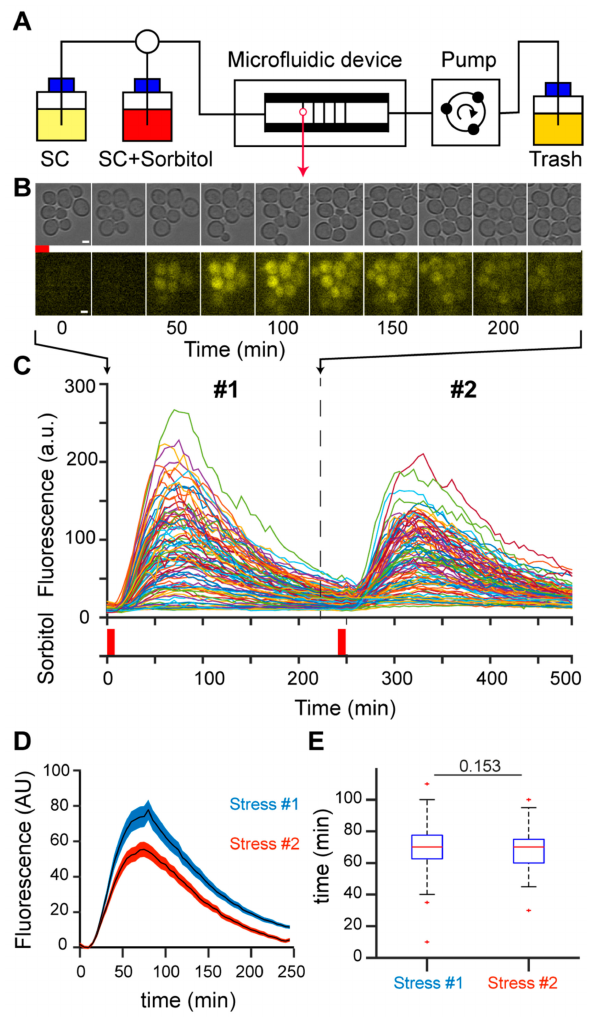
Figure 1. ( A ) Experimental setup. We used multi-layer H-shaped microfluidic devices composed of two large 50 µ m-high and 40- µ m thick flow channels, with 400 µ m × 400 µ m × 3.7 µ m observation chambers. Cells are trapped in the chambers and grow as a monolayer, which facilitates cell segmentation and tracking. The medium flowed through the channels di ff uses into the chambers. Hyperosmotic stress-activated expression of pSTL1-yECRITRINE was triggered by exposure to 1 M sorbitol for 8 min. SC, synthetic complete medium. ( B ) Representative images of cells in the microfluidic chamber exposed to 8 min stress and left to recover for 4 h (240 min), scale bar, 5 µ m. Cells were imaged every 5 min in bright light (20 ms exposure, upper row) and fluorescent light (200 ms exposure, lower row). ( C ) Fluorescent signals for individual cells exposed to two successive 8 min-stresses separated by 4 h. Hyperosmotic stress is indicated by the red bars, # 1 and # 2 indicate first and second stress, respectively. ( D ) Fluorescence responses of a population of n = 97 cells. The mean ( ± standard error of the mean) responses of cells to a first stress (blue), followed by a second stress 4 h later (red) are represented. Fluorescence levels were normalized to the fluorescence value before each corresponding stress. The fluorescence peak decreased from the first to the second stress. ( E ) Analyses of the temporal responses to two consecutive stresses in the same population. The duration between stress induction and peak fluorescence was similar for the first and second